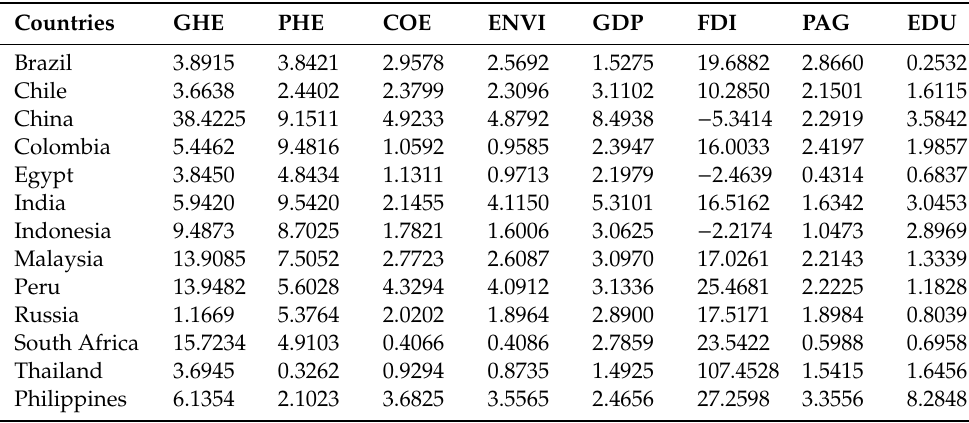
Table 2. Annual Average Growth